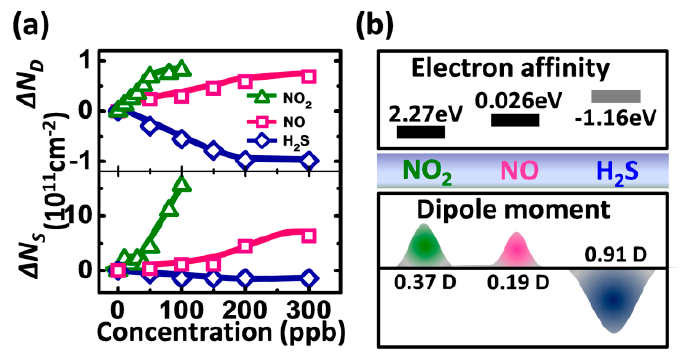
Figure 6. ( a ) changes of deep trap density ( Δ N D ) and shallow trap density ( Δ N S ) at semiconductor/dielectric interface as a function of NO 2 ( green triangle), NO ( pink square) and H 2 S ( blue rhombic) in dynamic concentrations; and ( b ) electron affinity and dipole moment of NO 2 , NO and H 2 S.